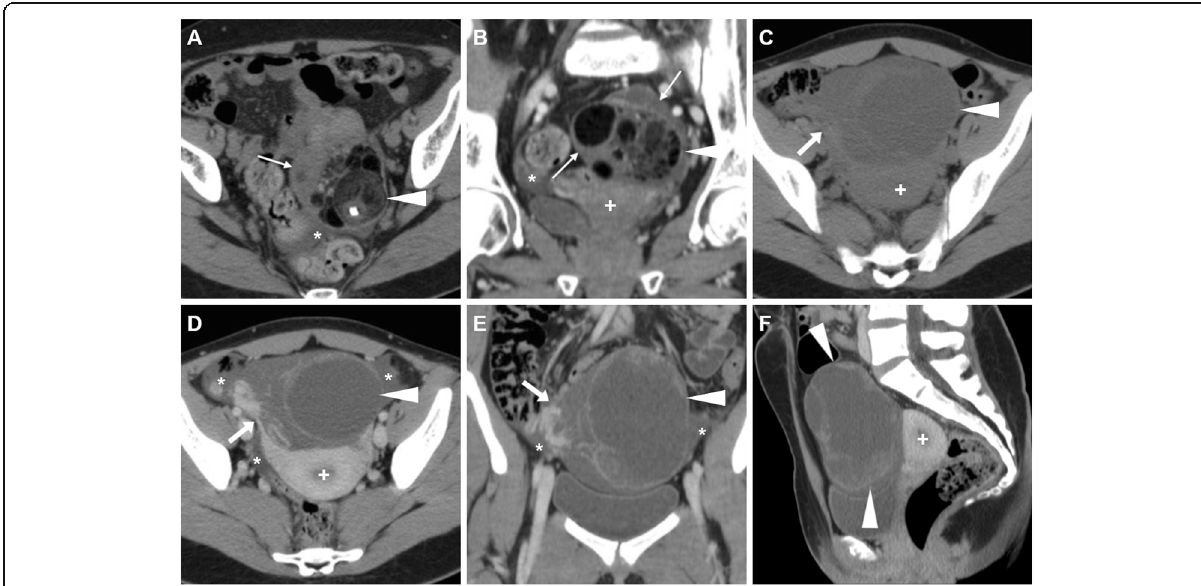
Fig. 18 Two surgically proven cases of adnexal torsion. a , b Axial ( a ) and coronal ( b ) CT images show enlarged left ovary (arrowheads) with thickened oedematous periphery (thin arrows), containing a mixed-attenuation roundish mass with fat-attenuation foci and a calcification, corresponding to a mature cystic teratoma. Note the ipsilateral attraction of uterus (+), minimal fluid in the peritoneal cul-de sac (asterisk in a ). c – f Unenhanced ( a ) and post-contrast ( d – f ) CT images show large midline pelvic mass (arrowheads) consistent with malignant teratoma with poor, irregular enhancement that displaces the uterus and bladder. Note the peritoneal effusion (asterisk) and congested ovarian vessels on the right side